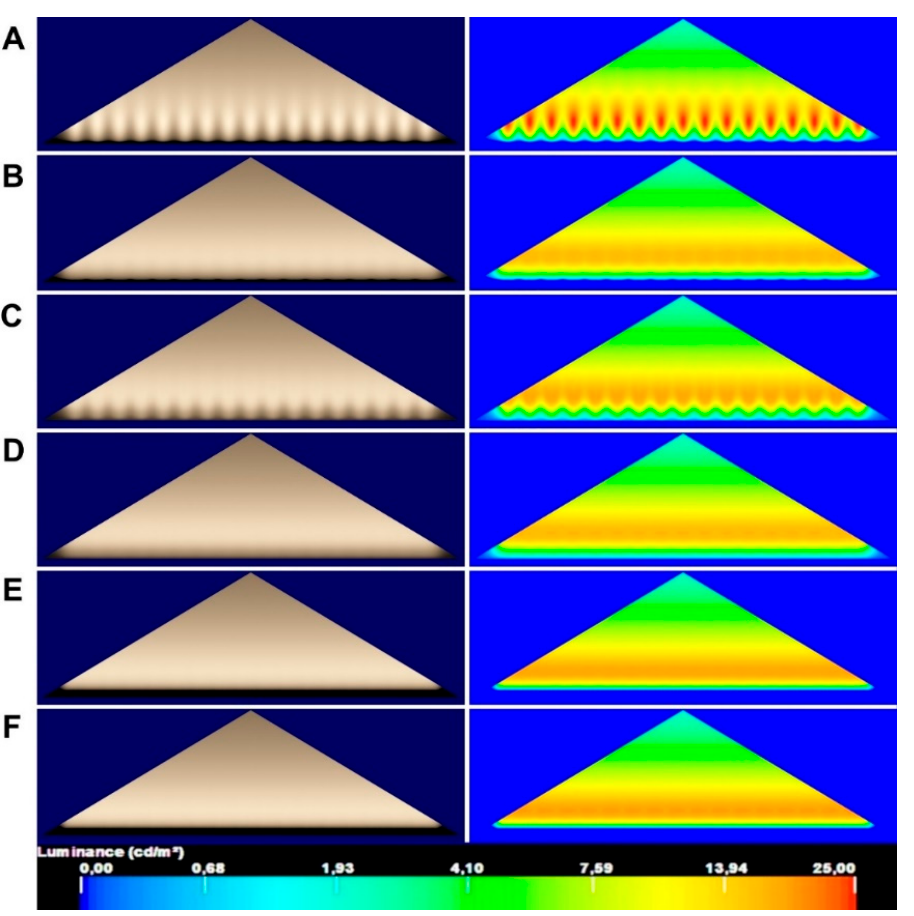
Figure 13. The visualizations and luminance distributions of the lighting for the tympanum (10 m/3 m) with the linear LED luminaires for different simulation variants. Both the photometric separation effect of the individual LED lenses of the luminaire and the photometric file carried out from a close distance improve the accuracy and created a more natural image of the visualization and the luminance distribution. Table 2. The results of the calculations of luminance for the illuminated tympanum in different lighting simulation cases. Number of TYPE CASE .ies